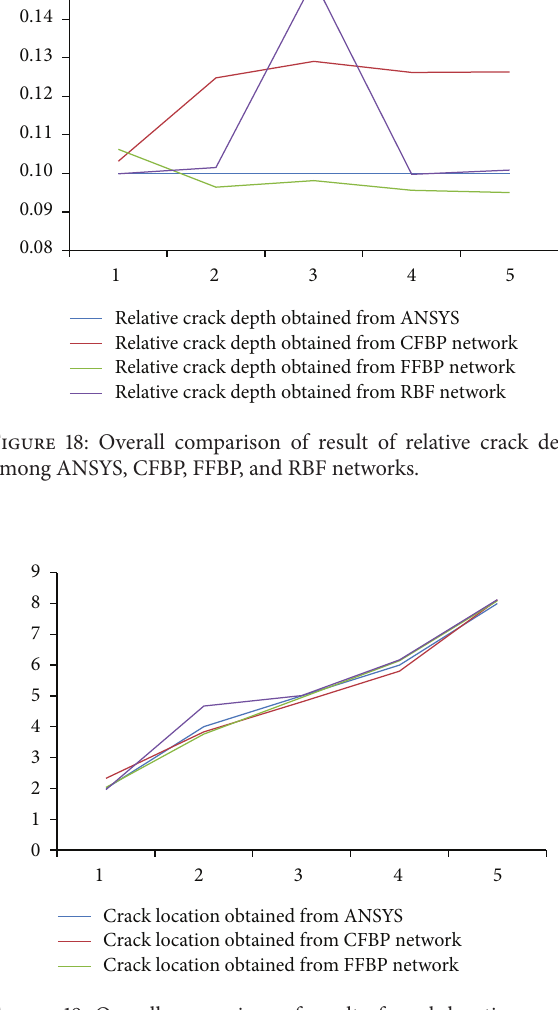
Figure 19: Overall comparison of result of crack location among ANSYS, CFBP, FFBP, and RBF